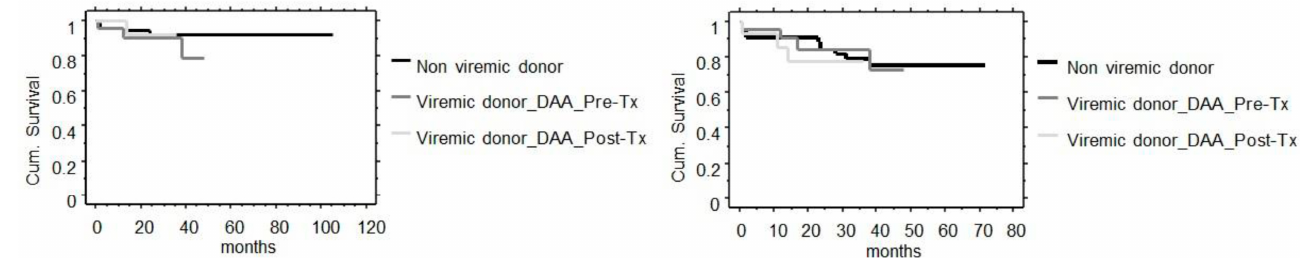
Figure 1. Patient ( left ) and graft survival including patients’ death ( right ) in recipients from non- viremic and viremic donors. p -value were non-significant by Kaplan – Meier analysis ( p = 0.415 and p = 0.741, respectively).